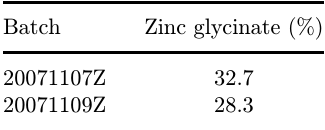
Table 4. The contents of zinc ion in zinc glycinate.